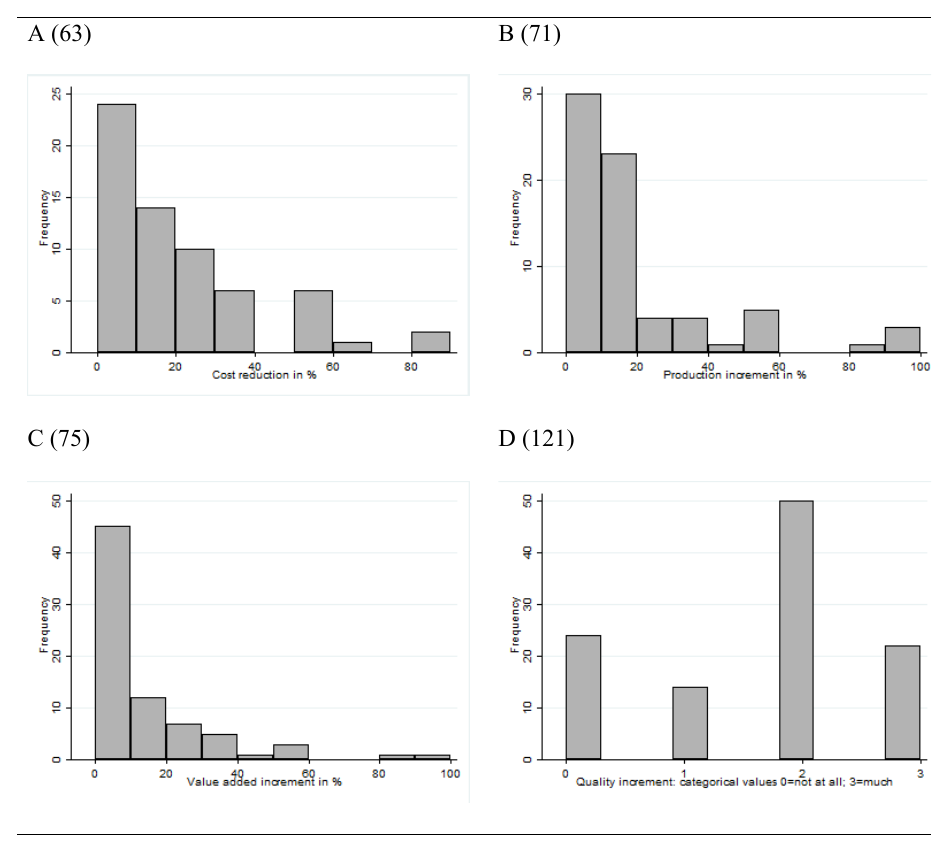
Figure 1. Frequency distribution of Cost Reduction (A), Production Increase (B), Value-Added Increase (C) and Quality Increase